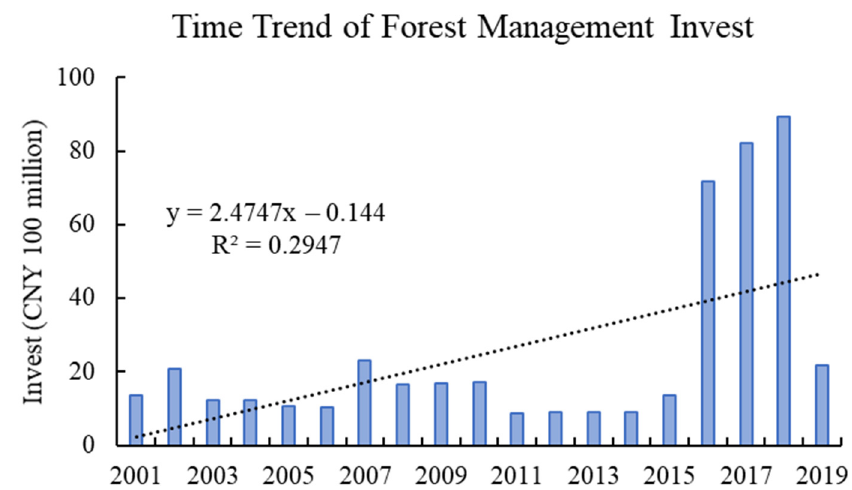
Figure 5. Temporal change in FMI in key SOFRs in Heilongjiang Province.